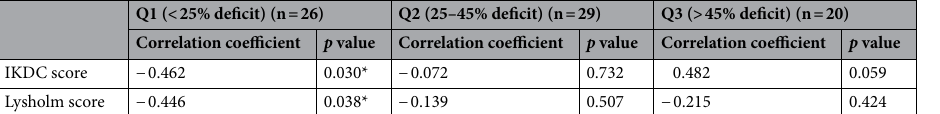
Q1 (< 25% deficit) (n =